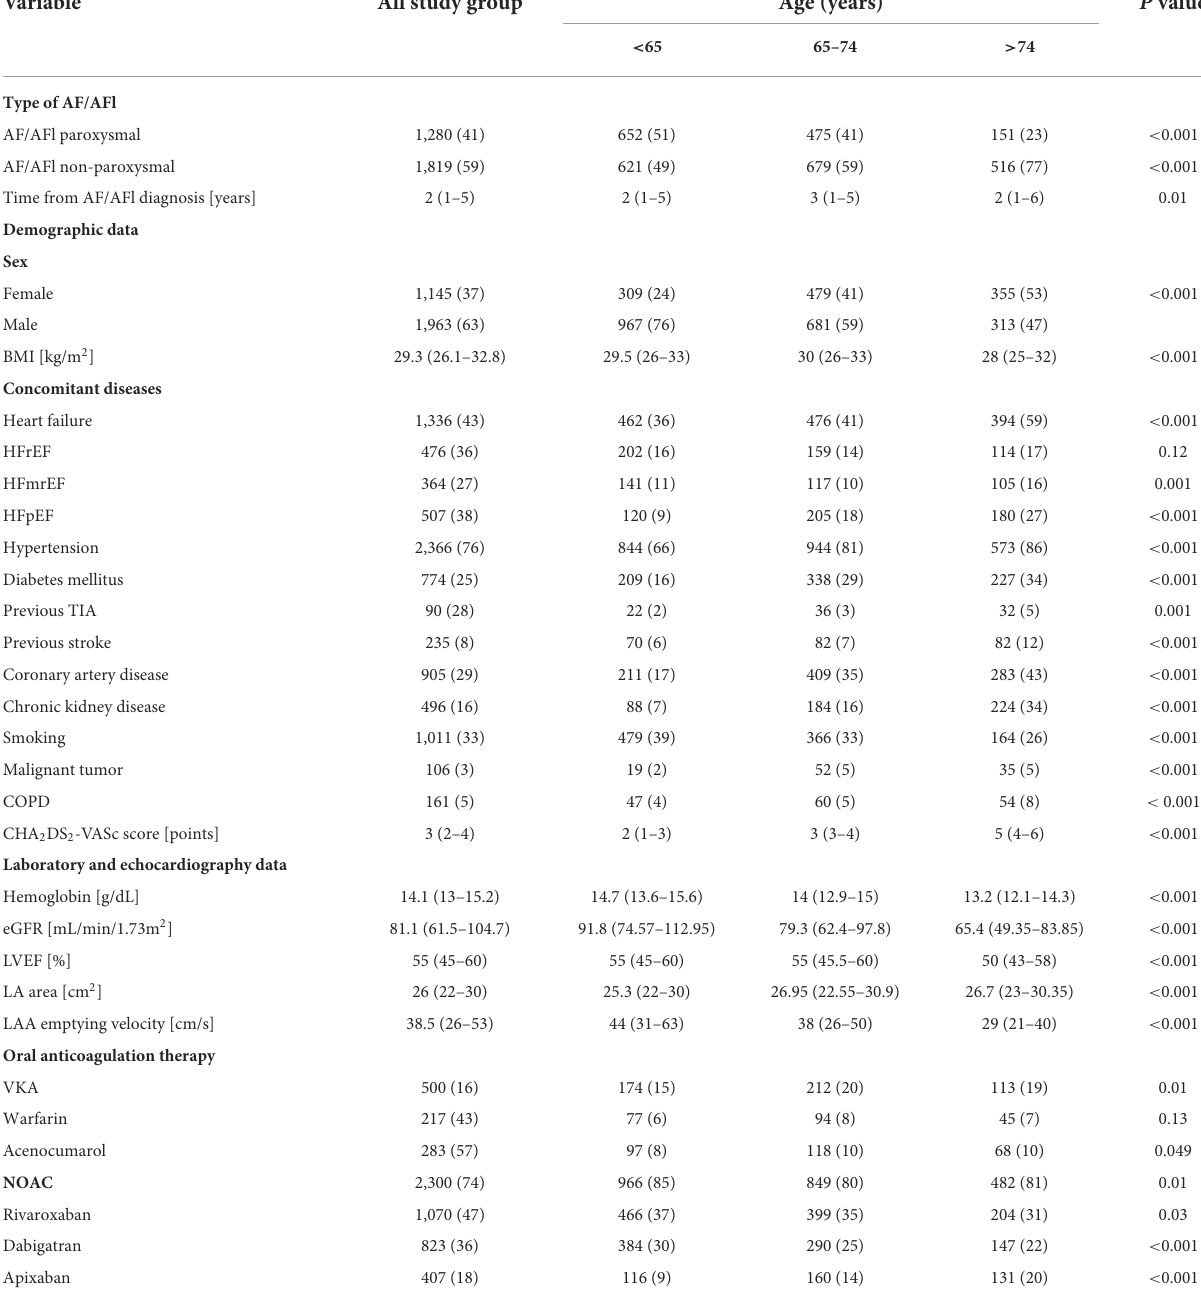
TABLE 1 Characteristics of the study group according to age